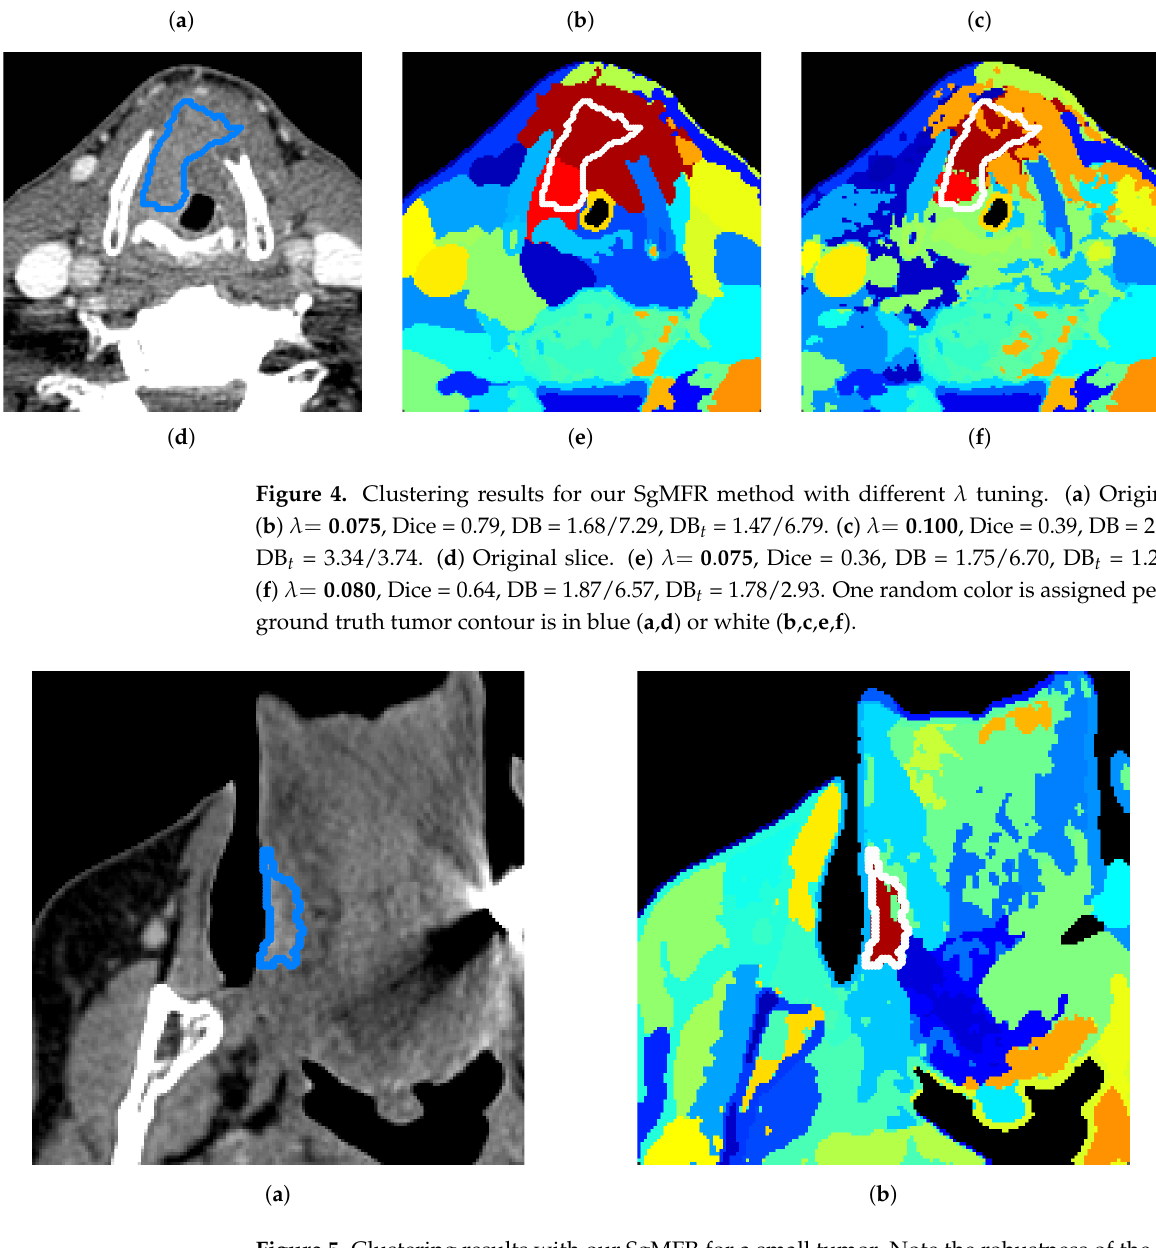
Figure 5. Clustering results with our SgMFR for a small tumor. Note the robustness of the result in the presence of a metallic artifact in the right-hand side of the anatomical image. ( a ) Original